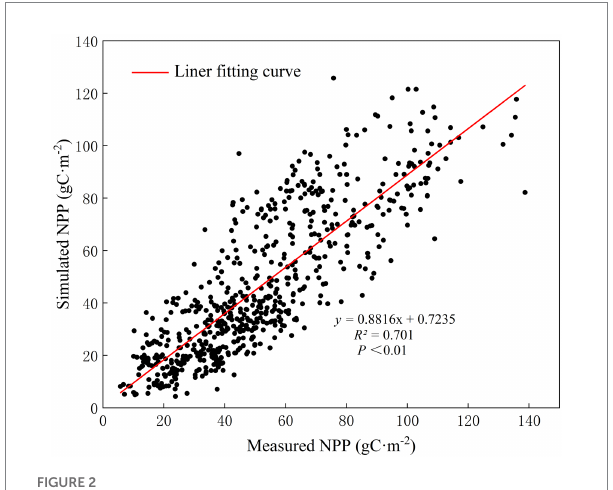
FIGURE 2 NPP model accuracy